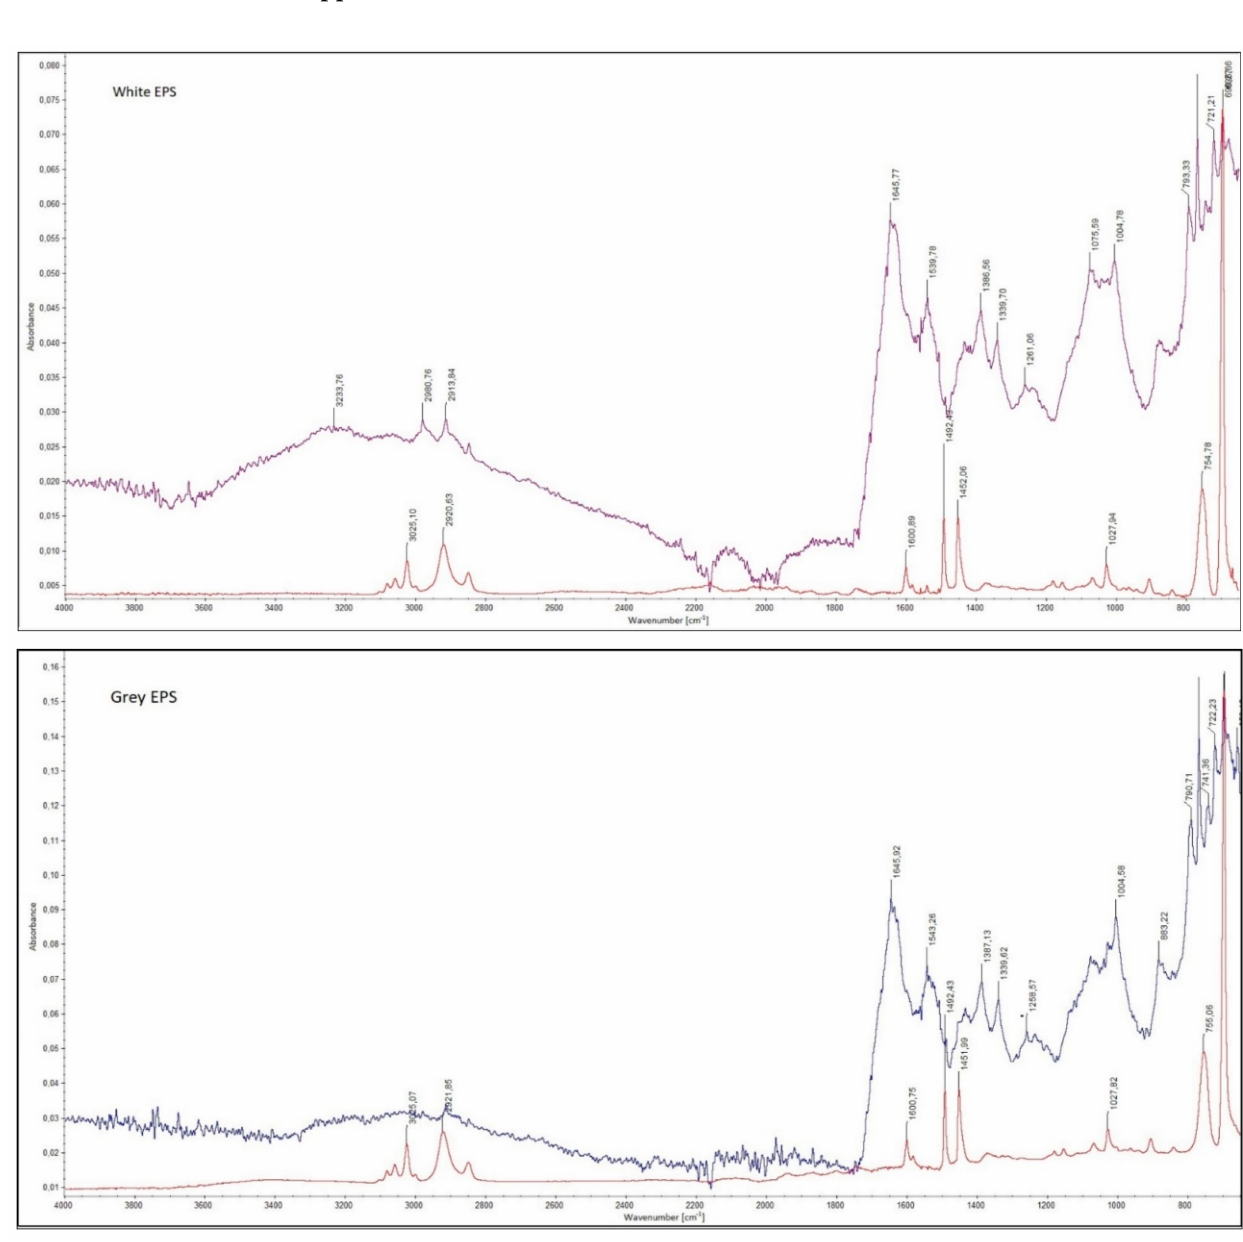
Figure A1. FTIR analysis of